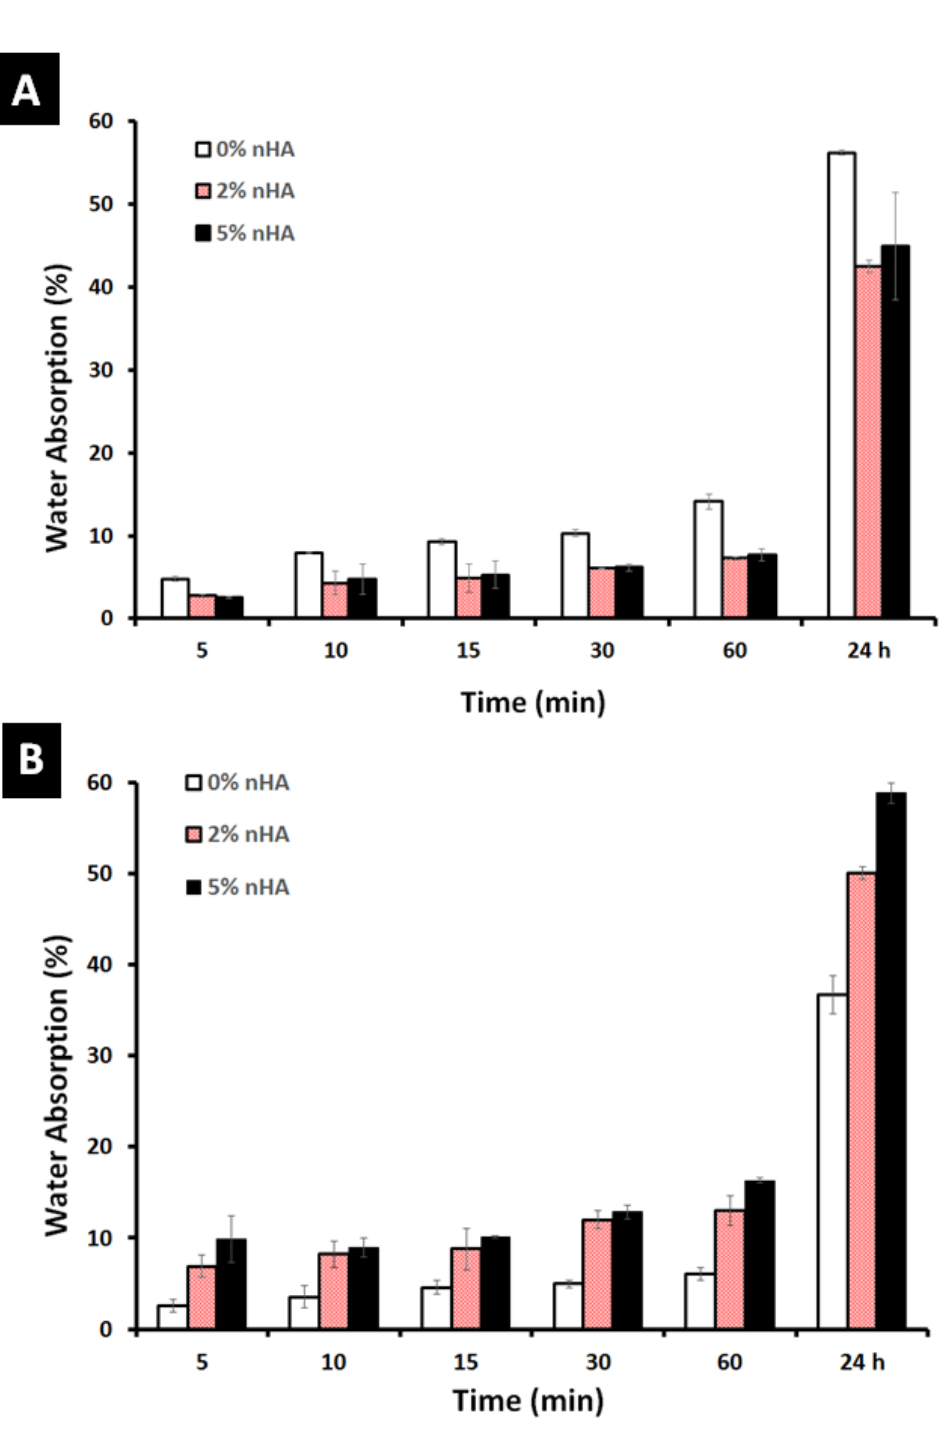
Figure 8. Water absorption versus time for ( A ) 15% GA/chitosan hydrogels, and ( B ) 5% GA/chitosan hydrogels with 0, 2, and 5% nHA using deionized water at room temperature.